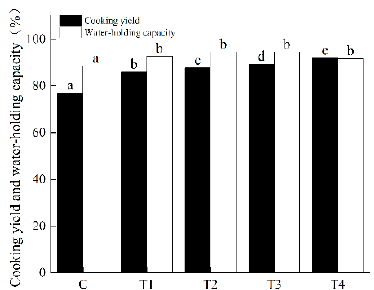
Figure 1. Cooking yield and water-holding capacity of cooked pork batters prepared with various amounts of ORP; C: meat batter without ORP; T1: meat batter containing 1% ORP; T2: meat batter containing 2% ORP; T3: meat batter containing 3% ORP; T4: meat batter containing 4% ORP; different lowercase letters from black column (a, b, c, d, e) indicate significant differences ( p < 0.05) in cooking yield; different lowercase letters from white column (a, b) indicate significant differences ( p < 0.05) in